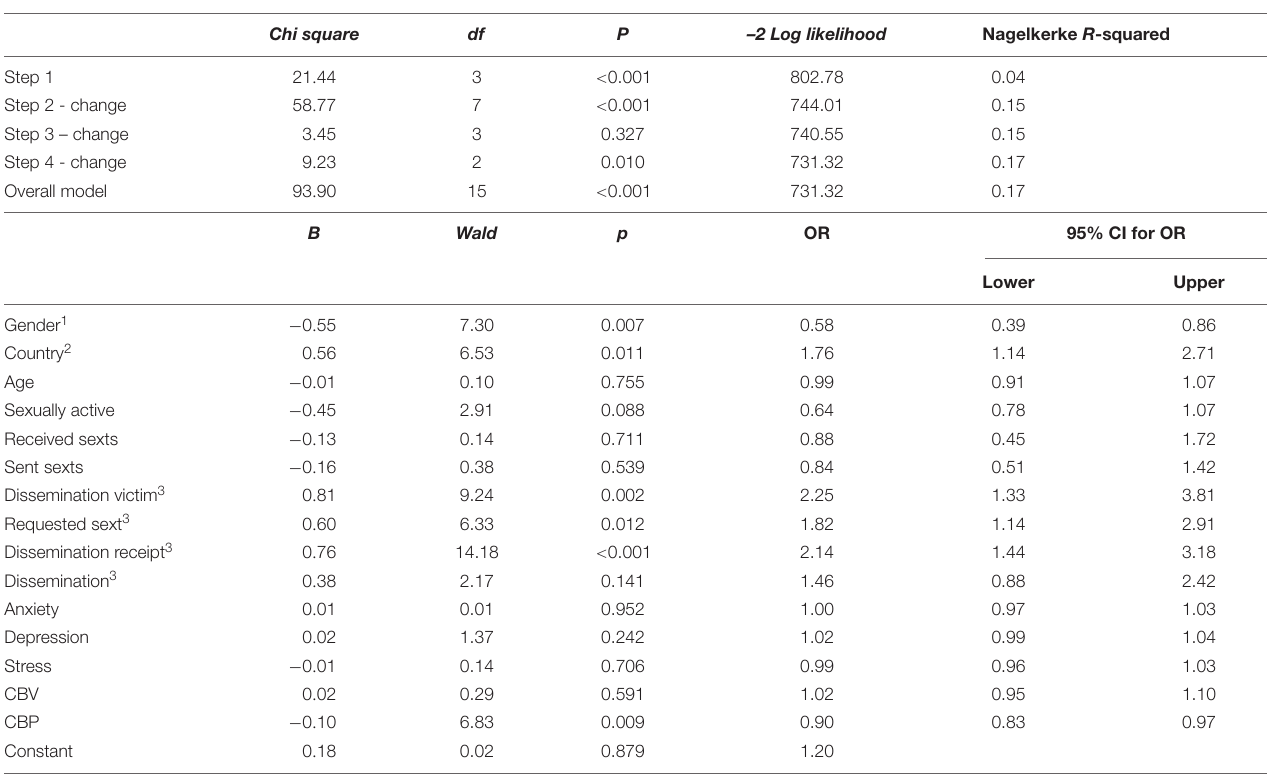
TABLE 4 | Hierarchical regression results – predictors of OIBEV site visitation